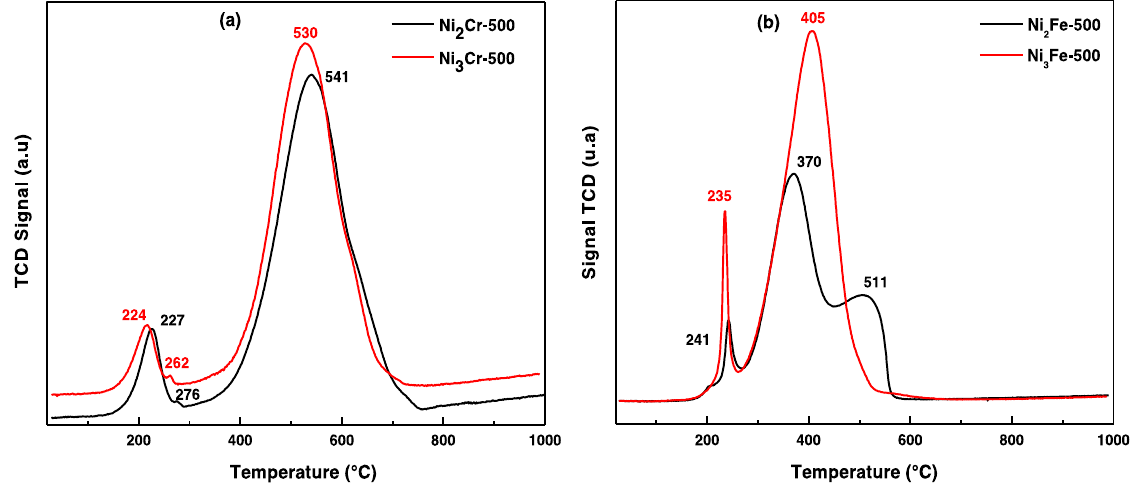
Figure 9. H 2 -TPR profiles of Ni R Cr-500 ( a ) and Ni R Fe-500 ( b ).